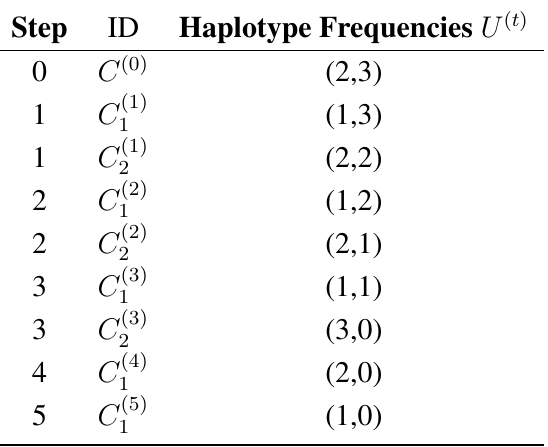
Table 1. Haplotype IDs and frequencies in each step of the